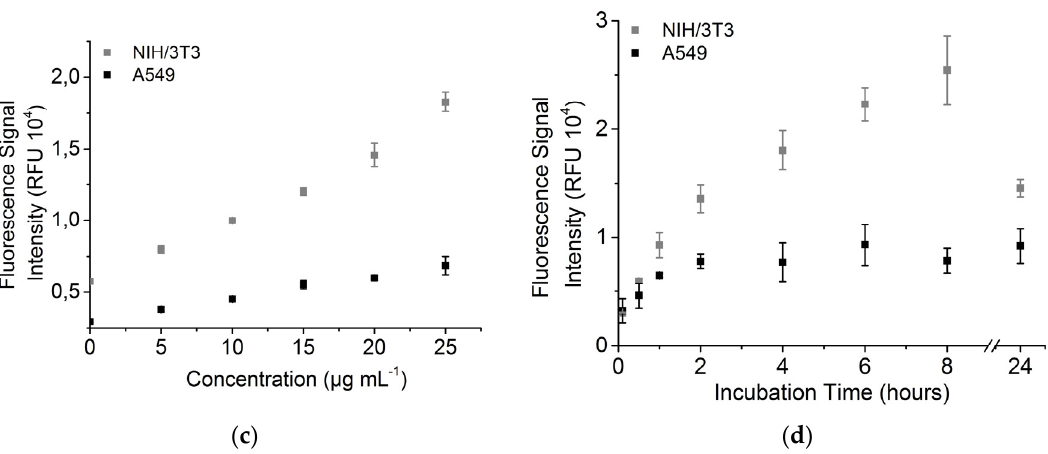
Figure 5. Fluorescence signal of A549 and NIH/3T3 cells. ( a ) Histogram of fluorescence signal with 0 μ g mL − 1 and 25 μ g mL − 1 TiO 2 NPs (NIH/3T3); ( b ) Histogram of fluorescence signal after 0 h and 24 h incubation with 12.5 μ g mL − 1 FITC ‐ TiO 2 NPs (NIH/3T3); ( c ) Fluorescence signal after incubation with different FITC ‐ TiO 2 NP concentrations for 24 h; ( d ) Uptake kinetic of FITC ‐ TiO 2 NPs with 12.5 μ g ∙ mL − 1 , signal has been normalized to control (cells without NPs).